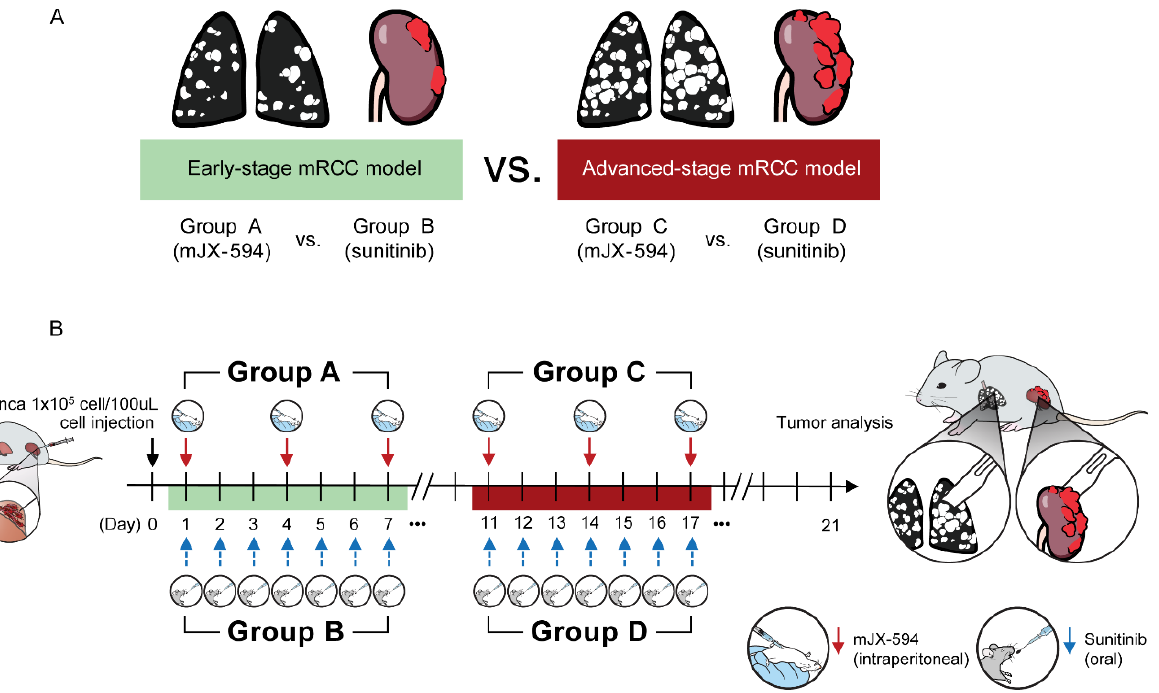
Figure 1. Two pulmonary metastatic orthotopic renal cell carcinoma murine models. ( A ) An early- stage metastatic renal cell carcinoma (mRCC) model was used to compare groups A (mJX-594 monotherapy) and B (sunitinib monotherapy). The advanced-stage mRCC model was used to compare groups C (mJX-594 monotherapy) and D (sunitinib monotherapy). ( B ) In vivo selected tumor cells from pulmonary metastases for reimplanted (1 × 10 5 cells/100 μ L) and treatments started on the first day of implantation for groups A and B. For groups C and D, treatments started on the 11th day of implantation. mJX-594 was intraperitoneally injected every 3 days for three times, whereas sunitinib was treated by gavage daily for 7 days. After the 21st day of injection, analysis was performed.